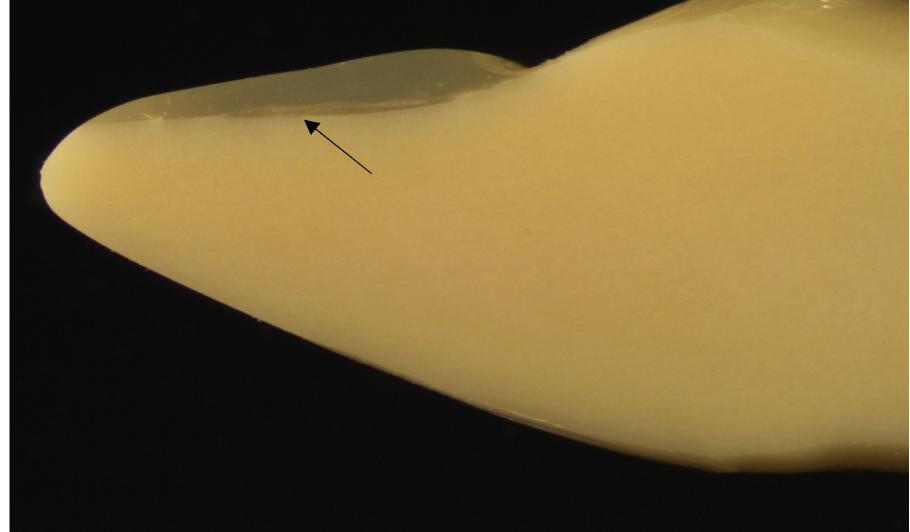
Figure 2. The photograph of the longitudinal section of Frasaco tooth with a bonded FRC retainer and flowable resin composite cover showing the FRC retainer, which is adapted to the surface of the tooth. The arrow points the place of the